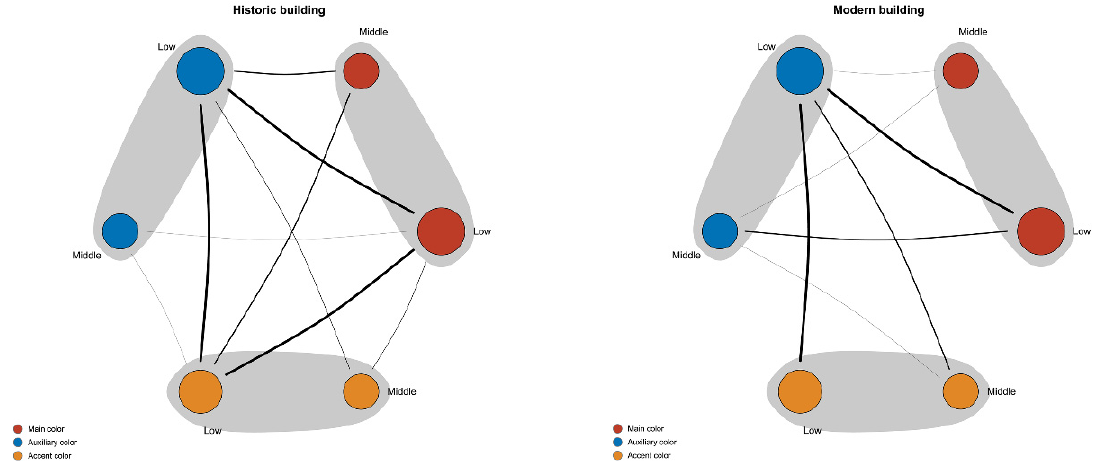
Figure 12. Composition network of color purity levels of historic and modern buildings.